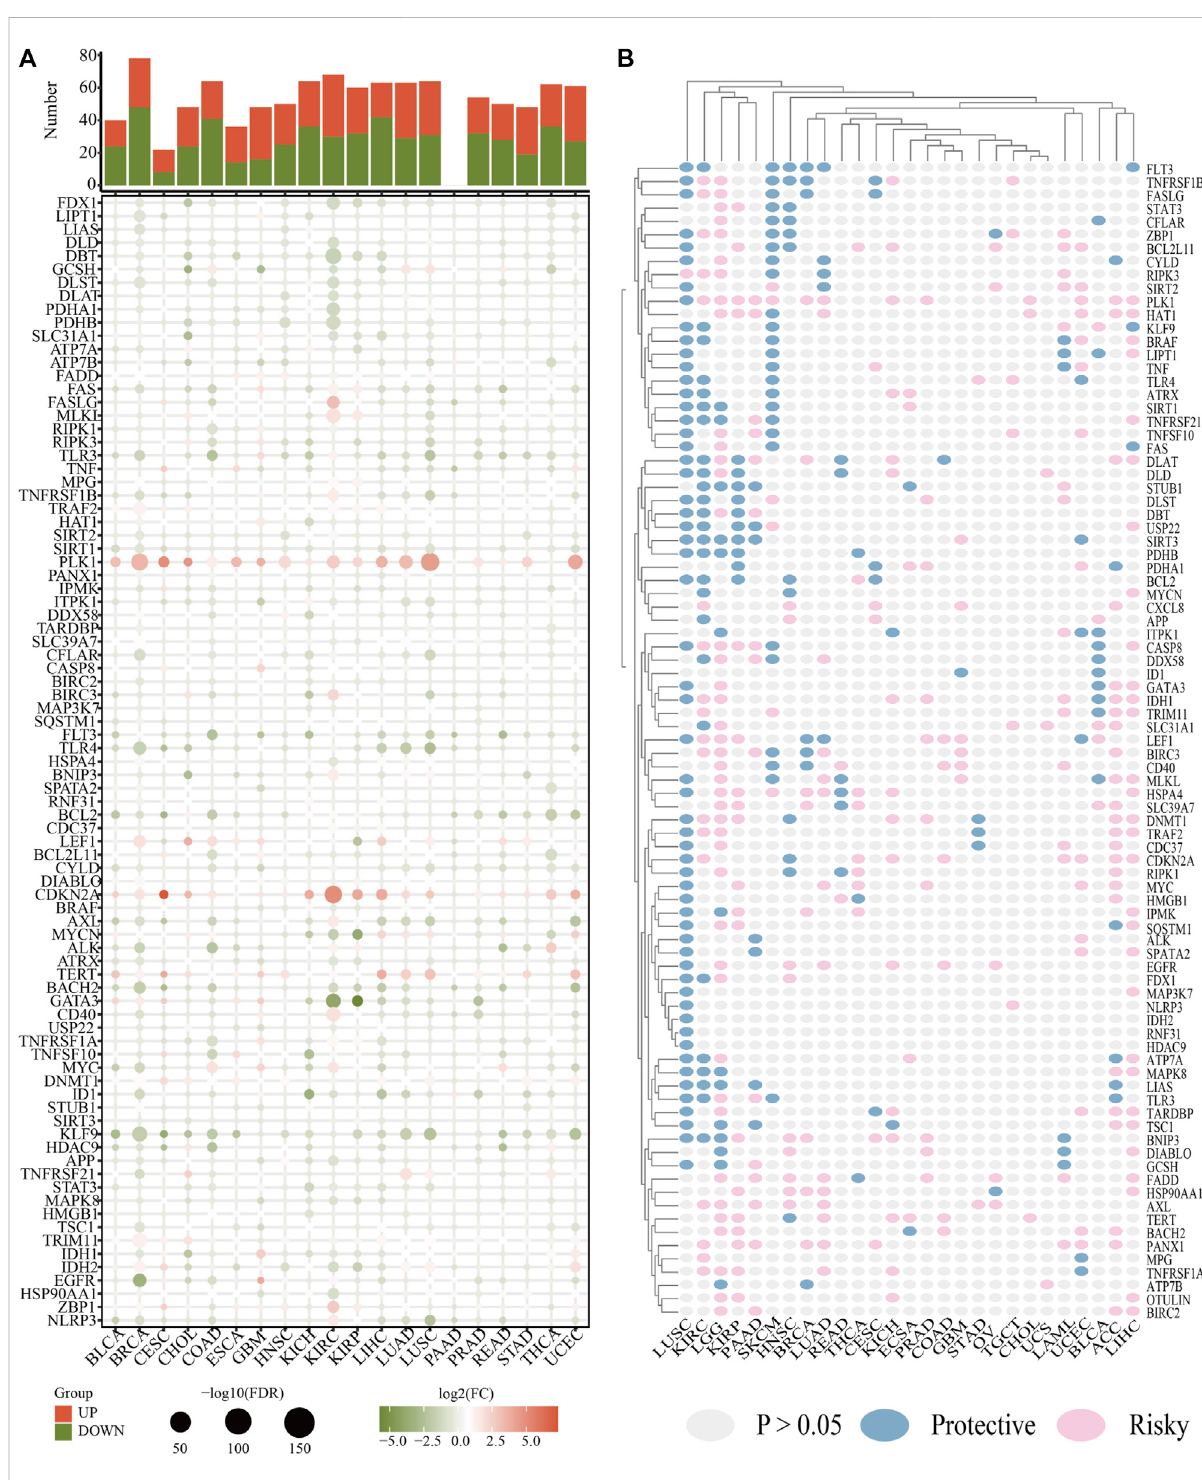
FIGURE 2 The roles of CNRGs in cancer. (A) The heatmap depicts the fold change and FDR of CNRGs in each tumour, whereas the histogram (top panel) shows the number of signi fi cantly differentially expressed genes. (B) Heatmap showed the survival landscape of